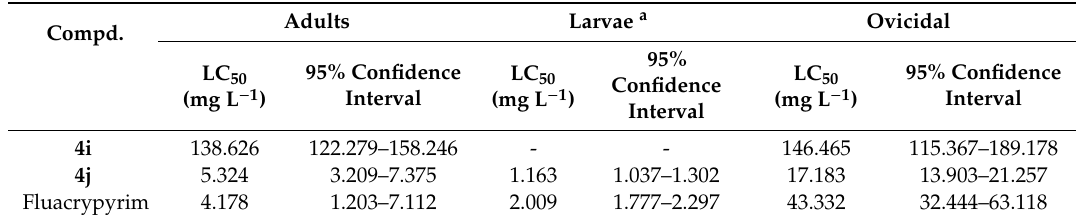
Table 4. LC 50 of the acaricidal activity against T. cinnabarinus.